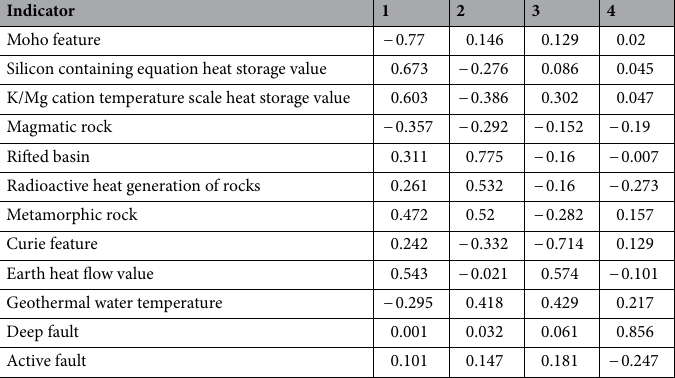
Table 2. Component matrix of spss software principal component analysis (PCA)